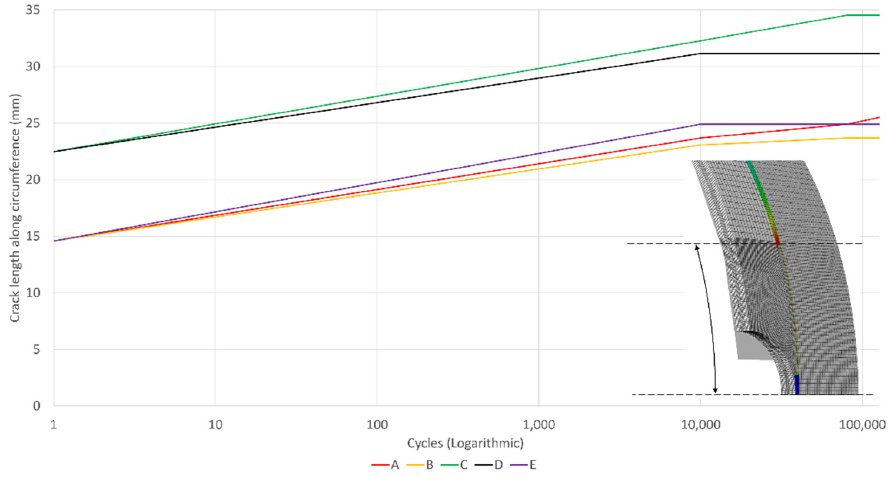
Figure 28. Shear crack length (length that has breached δ 0 in Figure 7) along the circumference of the FEA model.